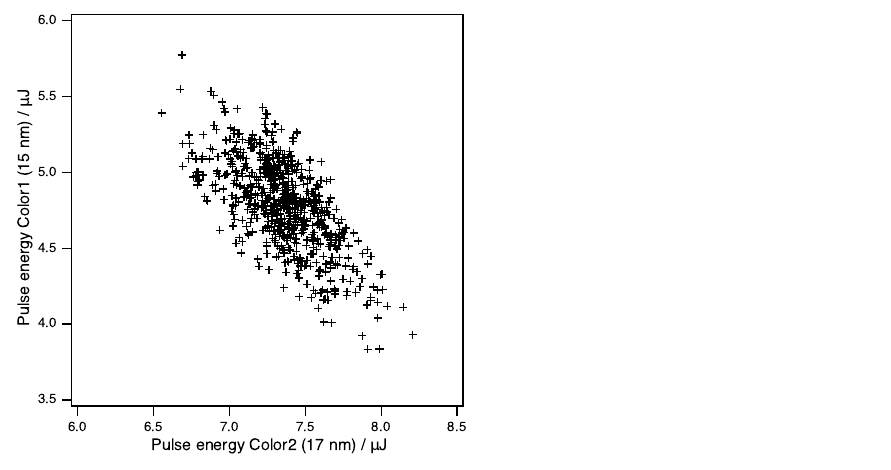
Figure 7. Correlation plot of pulse energies at 15 nm and 17 nm measured with the grating spectrometer. Continuous monitoring of spectral features is possible using the OPIS spectrometer.